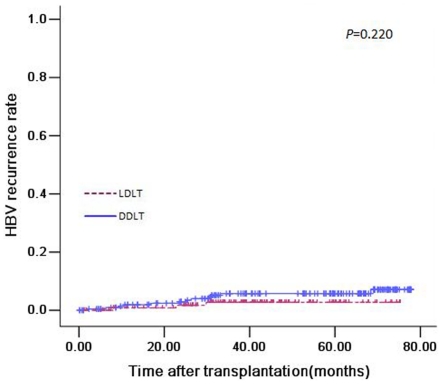
HBV recurrence curve in patients undergoing LDLT versus DDLT (P = 0.220).